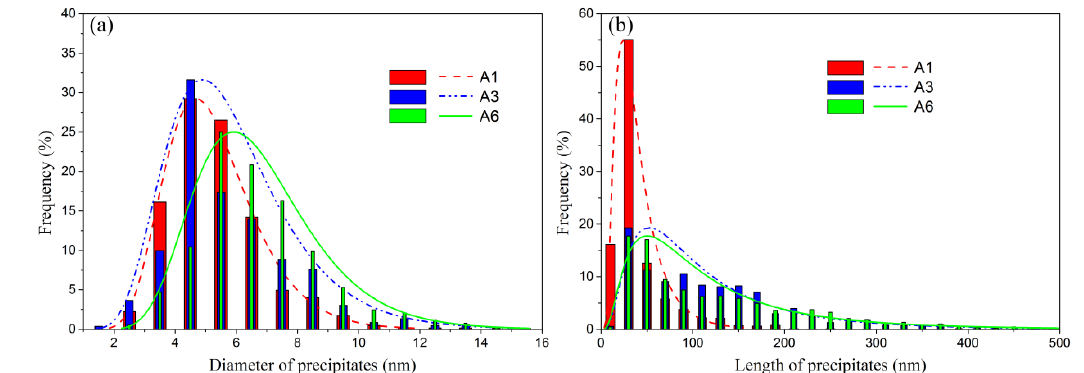
Figure 6. The distribution of ( a ) diameter and ( b ) length of precipitates within grains of the investigated